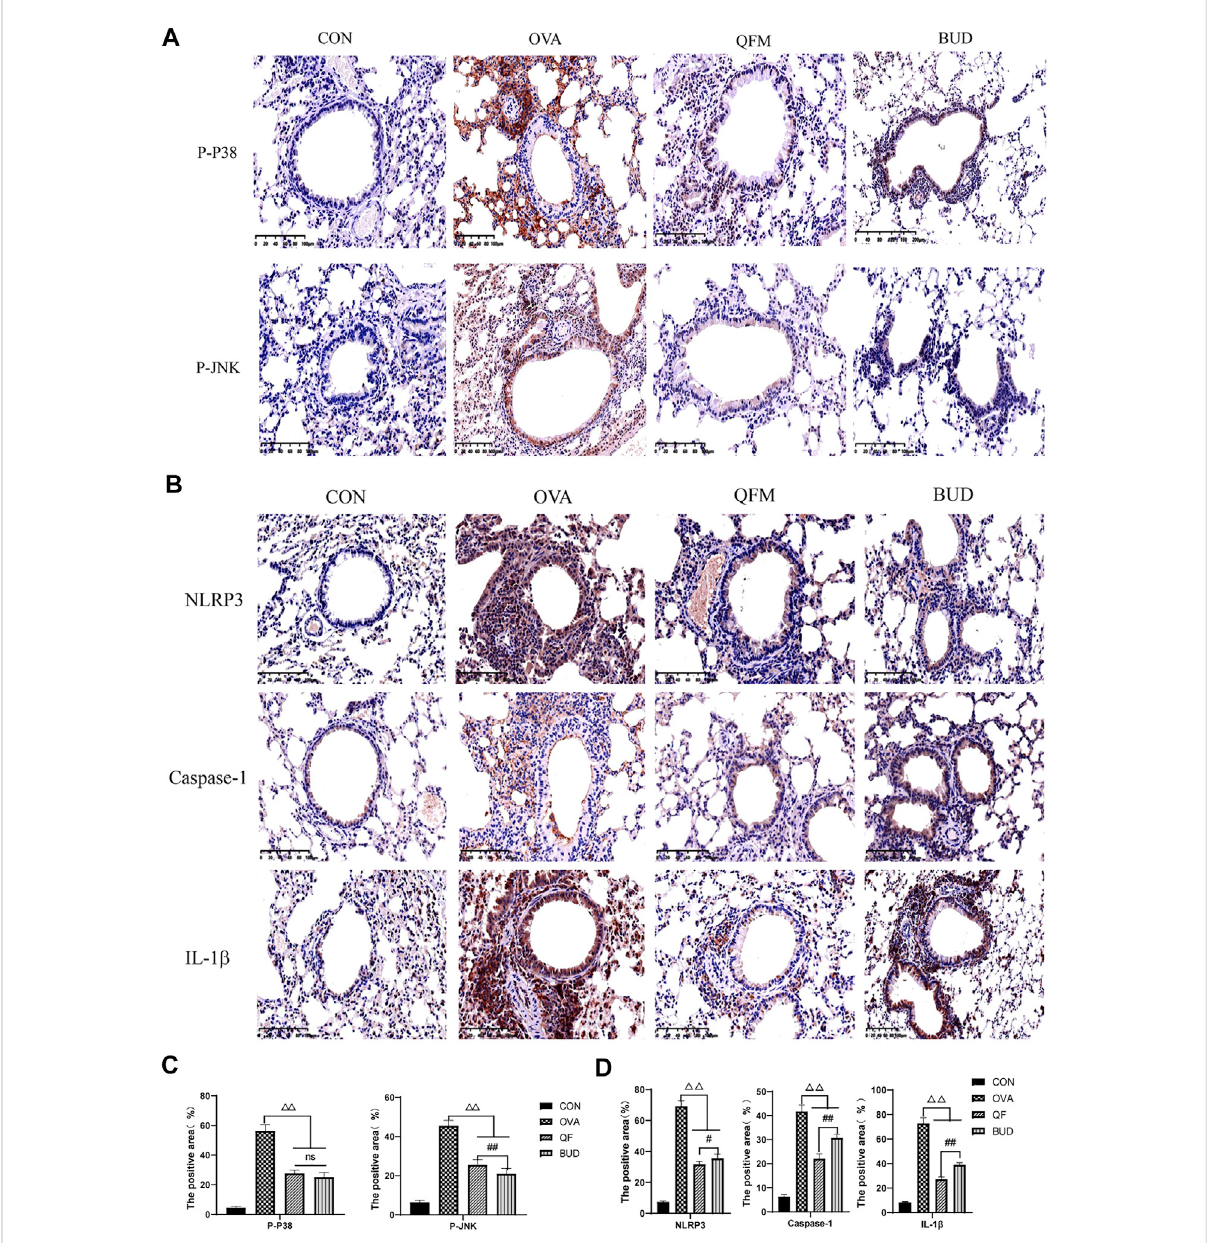
FIGURE 8 Effects of Qingfei oral liquid (QF) on the expression of key proteins related to MAPK and NOD-like receptor signal pathway. (A) Representative immunohistochemistry staining of p-P38 and p-JNK (200×, Brown particles represent positive protein expression). (B) Representative immunohistochemistrystainingofNLRP3,caspase-1,andIL-1 β (precursorIL-1 β andcleavedIL-1 β )(200×,Brownparticlesrepresentpositiveprotein expression). (C) The positive area of p-P38 and p-JNK (%). (D) The positive area of NLRP3, caspase-1, and IL-1 β (%). Each bar represents the mean ± standard deviation (SD). For all of these key proteins, there were signi fi cant differences between the control and the OVA groups ( p ≤ 0.01). ( n = 6, △ p ≤ 0.05 vs. the OVA group, △△ p ≤ 0.01 vs. the OVA group; # p ≤ 0.05 vs. the budesonide (BUD) group, ## p ≤ 0.01 vs. the BUD group; ns: no difference; one-way ANOVA followed by Tukey ’ s